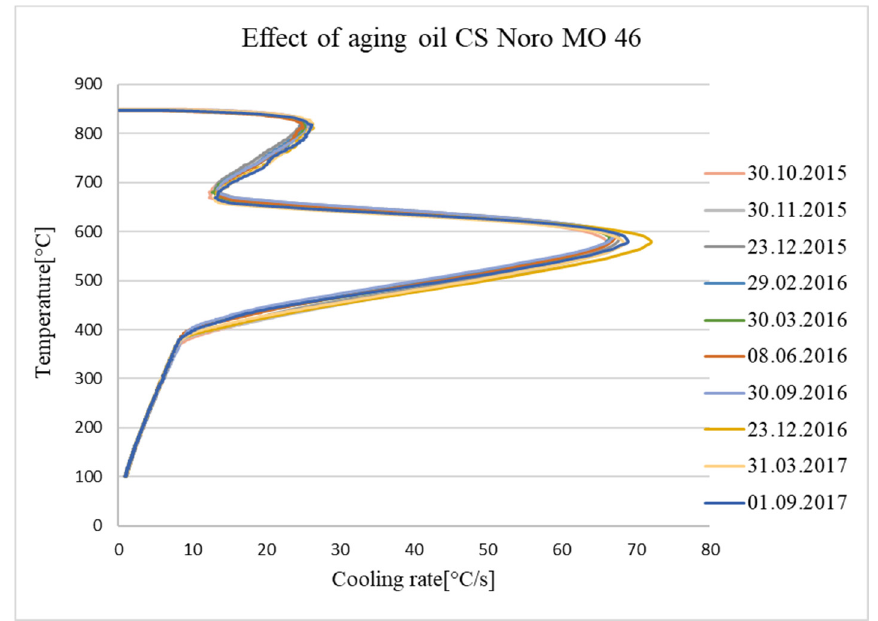
Figure 11. Ageing of CS Noro MO 46 oil.